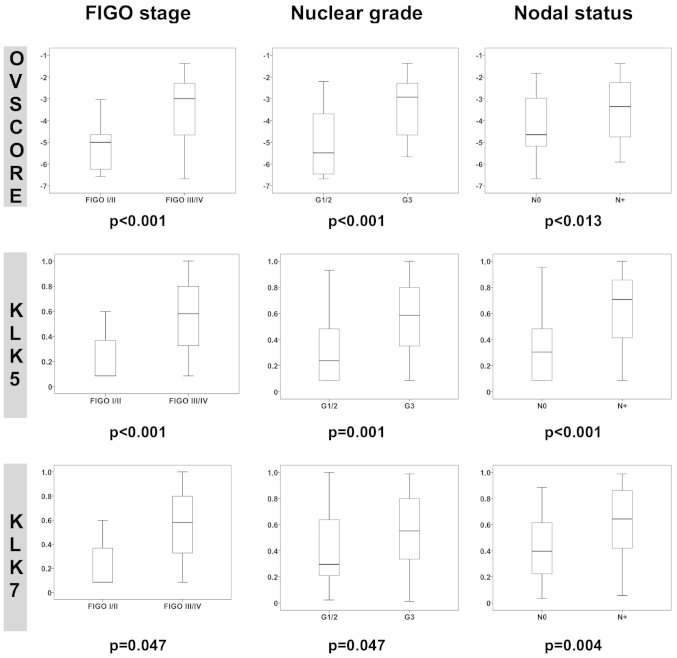
Boxplot diagrams showing correlations between FIGO stage, nuclear grade and nodal status with KLK5a, KLK7a and OVSCOREb in ovarian cancer patients. KLK5, KLK7 and OVSCORE values are significantly associated with advanced FIGO stage, higher nuclear grade and positive lymph node status. FIGO, International Federation of Gynecology and Obstetrics; KLK, kallikrein-related peptidase.